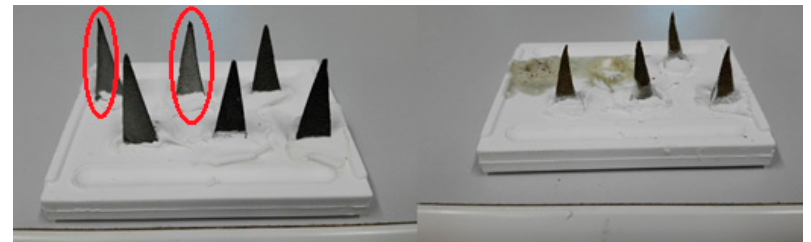
Figure 4. Comparison of samples before ( left ) and after measurement ( right ).